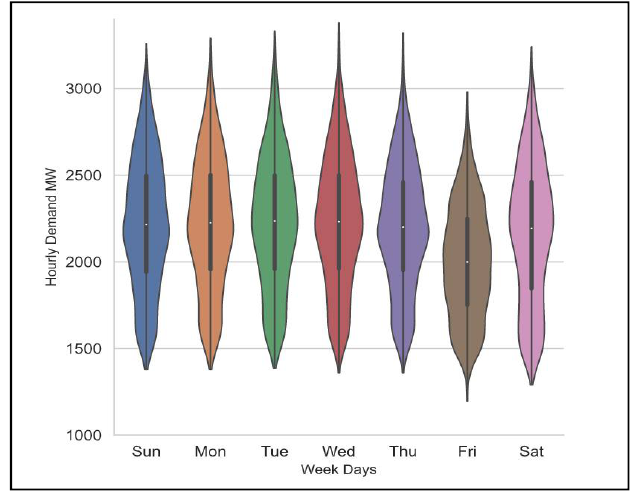
Figure 10. Weekly variation electrical demand, 2016–2019.